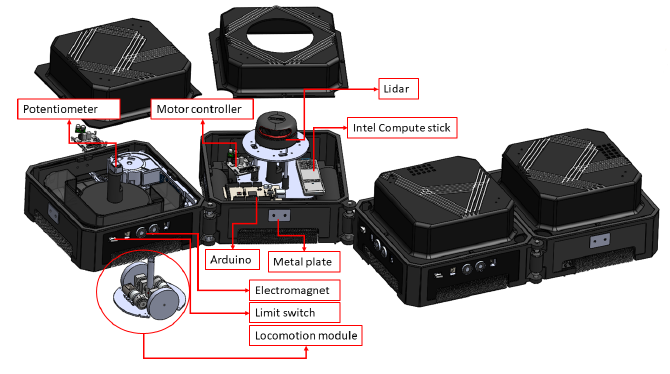
Figure 1. hTetro platform with hardware component setting.